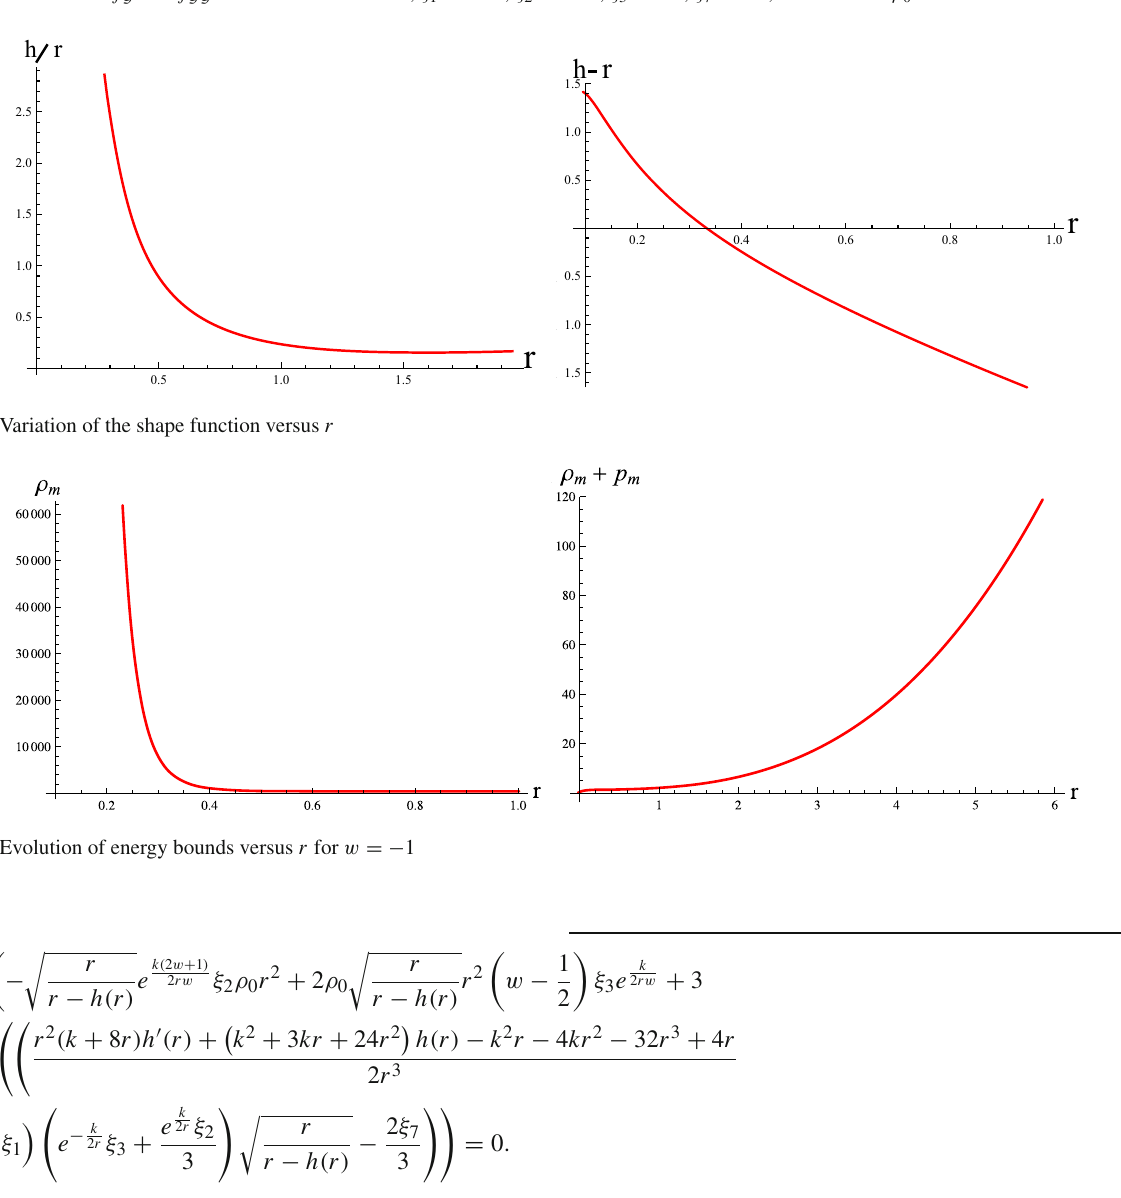
Fig. 1 Evolution of f G and f GG versus r for k = 0 . 005, ξ 1 = 0 . 01, ξ 2 = 0 . 85, ξ 3 = 0 . 1, ξ 7 = 0 . 5, w = − 1 and ρ 0 = 0 . 5